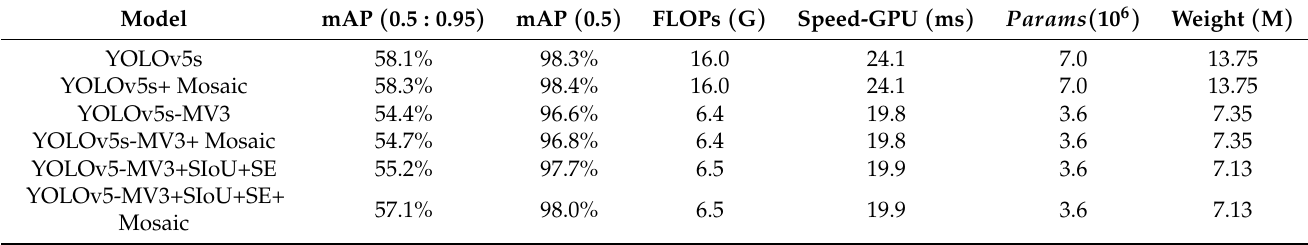
Figure 10. The comparison of the normalized confusion matrix between YOLOv5 and MR-YOLO. ( a ) The confusion matrix of the original YOLOV5 model; ( b ) The confusion matrix of our MR- YOLO model. Table 4. The result of ablation experiments with the Mosaic data enhancement.